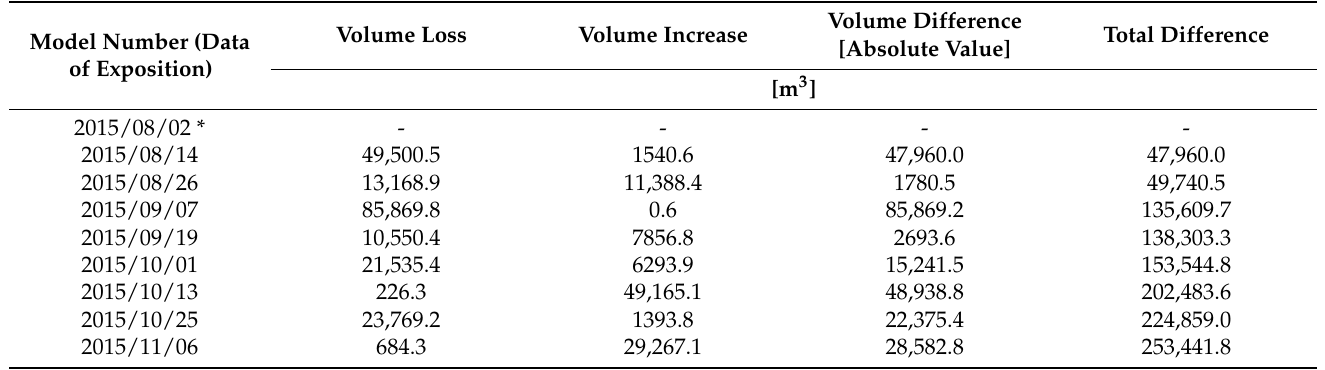
Table 3. Volume changes of the end moraine of the Werenskiold Glacier, based on SAR data. Model Number